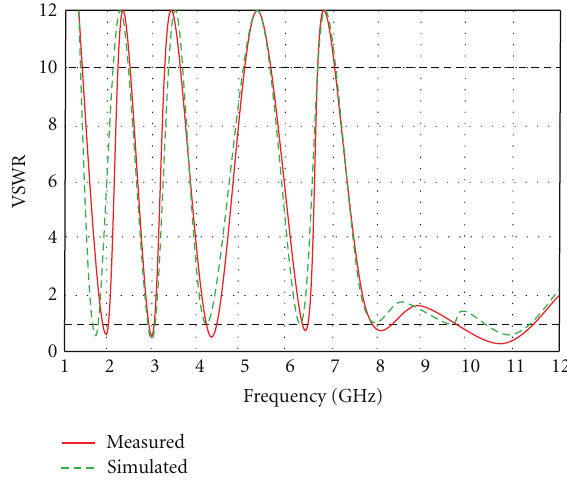
Figure 4: Simulated VSWR for various slot length “ L ” and thickness “ t ”.